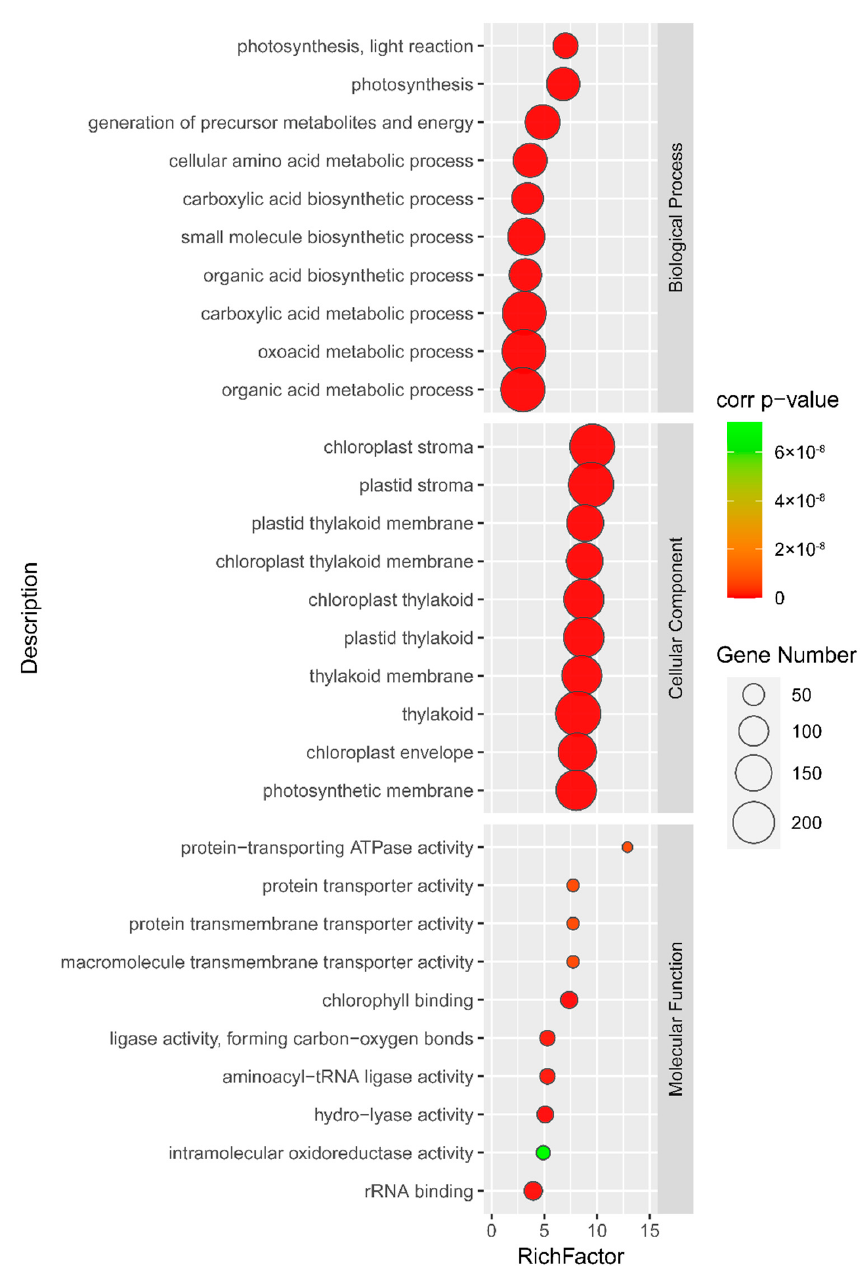
Figure 3. Statistics of GO enrichment analysis of the identified proteins. Gene ontology-based classification of the identified proteins according to their involvements in biological processes, cellular compartment, and molecular functions. The detailed information for the GO enrichment analysis is given in Supplementary Table S3.